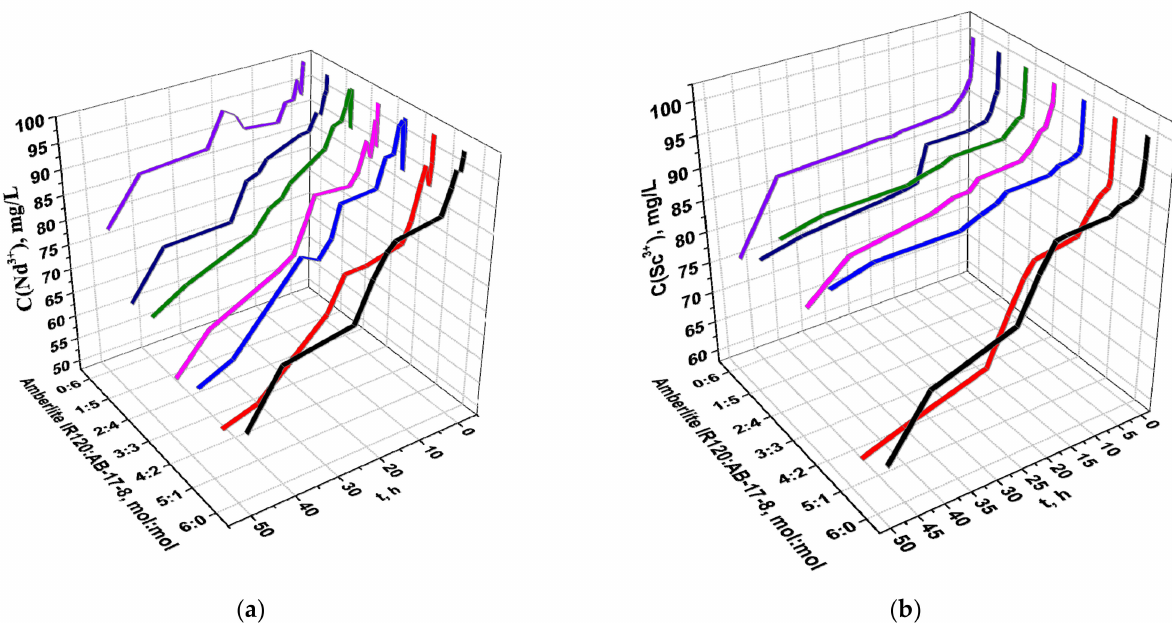
Figure 4. Change of concentration of Nd 3+ ( a ) and Sc 3+ ( b ) ions in the presence of the interpolymer system Amberlite